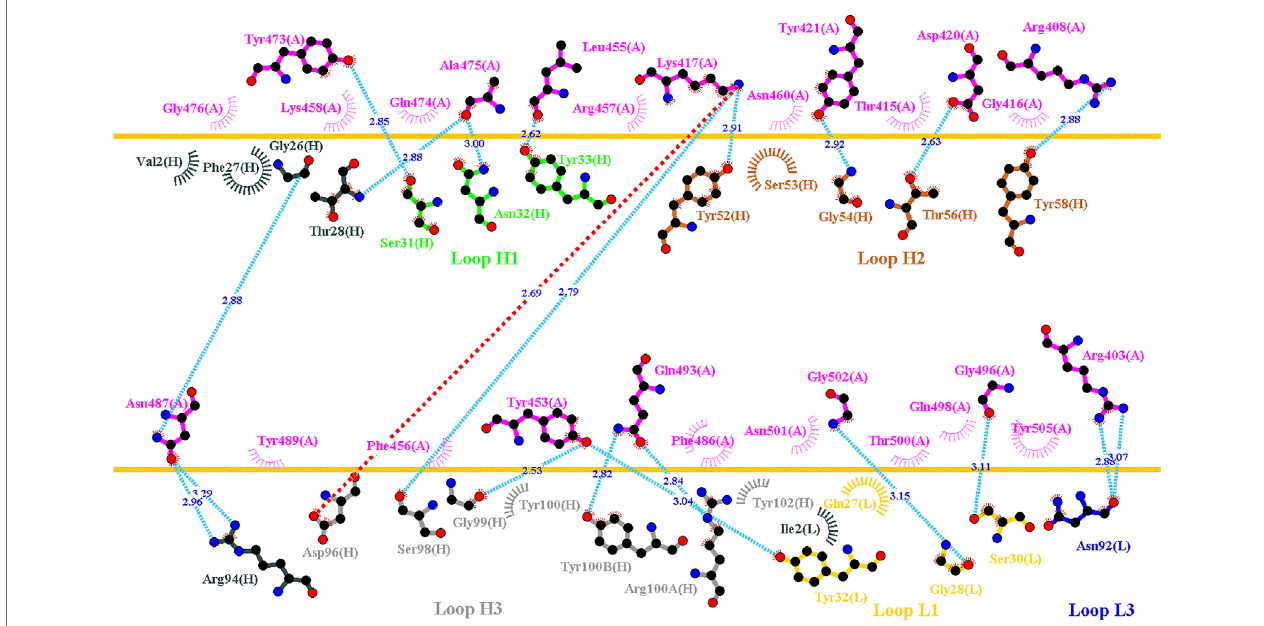
FIGURE 8 | Interactional network of the RBD and CA1-B3 antibody analyzed using LIGPLOT. LIGPLOT was employed to examine the interaction network of the SARS-CoV-2RBDandCA1-B3.TheRBDand lightandheavychainsofCA1-B3arelabeledA,H,and L,respectively.Thegoldenyellowlinedenotestheinterfaceofthe RBD – CA1-B3 complex. The interactive residues of the RBD were labeled and colored magenta. The salt-bridges, hydrogen bonds and hydrophobic interactions are represented by red, cyan dashes and arcs with spokes radiating toward the ligand atoms with which they are contact,